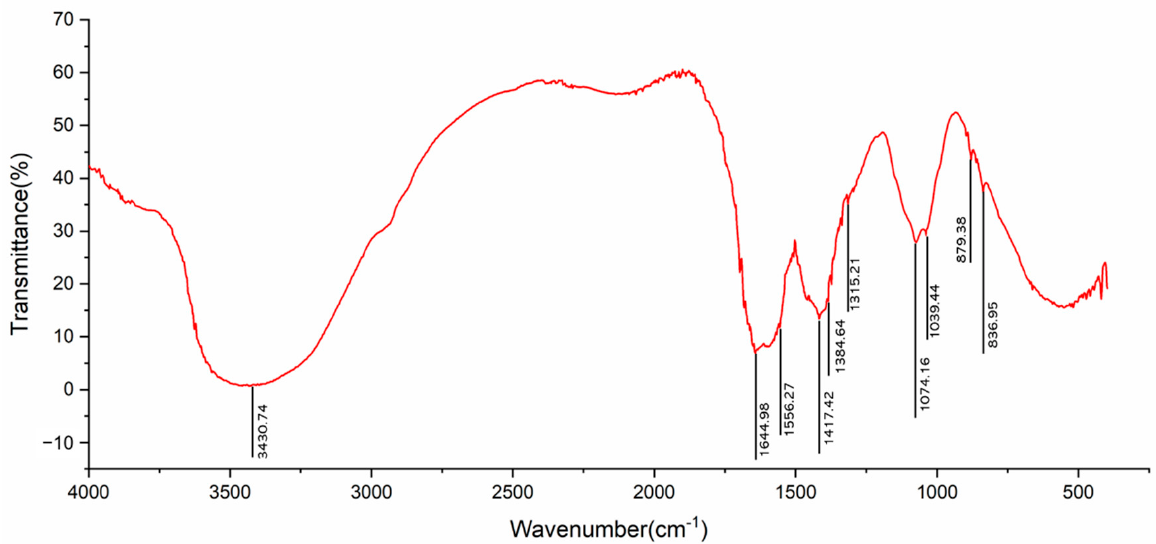
Figure 1. Infrared spectrum of LBP.